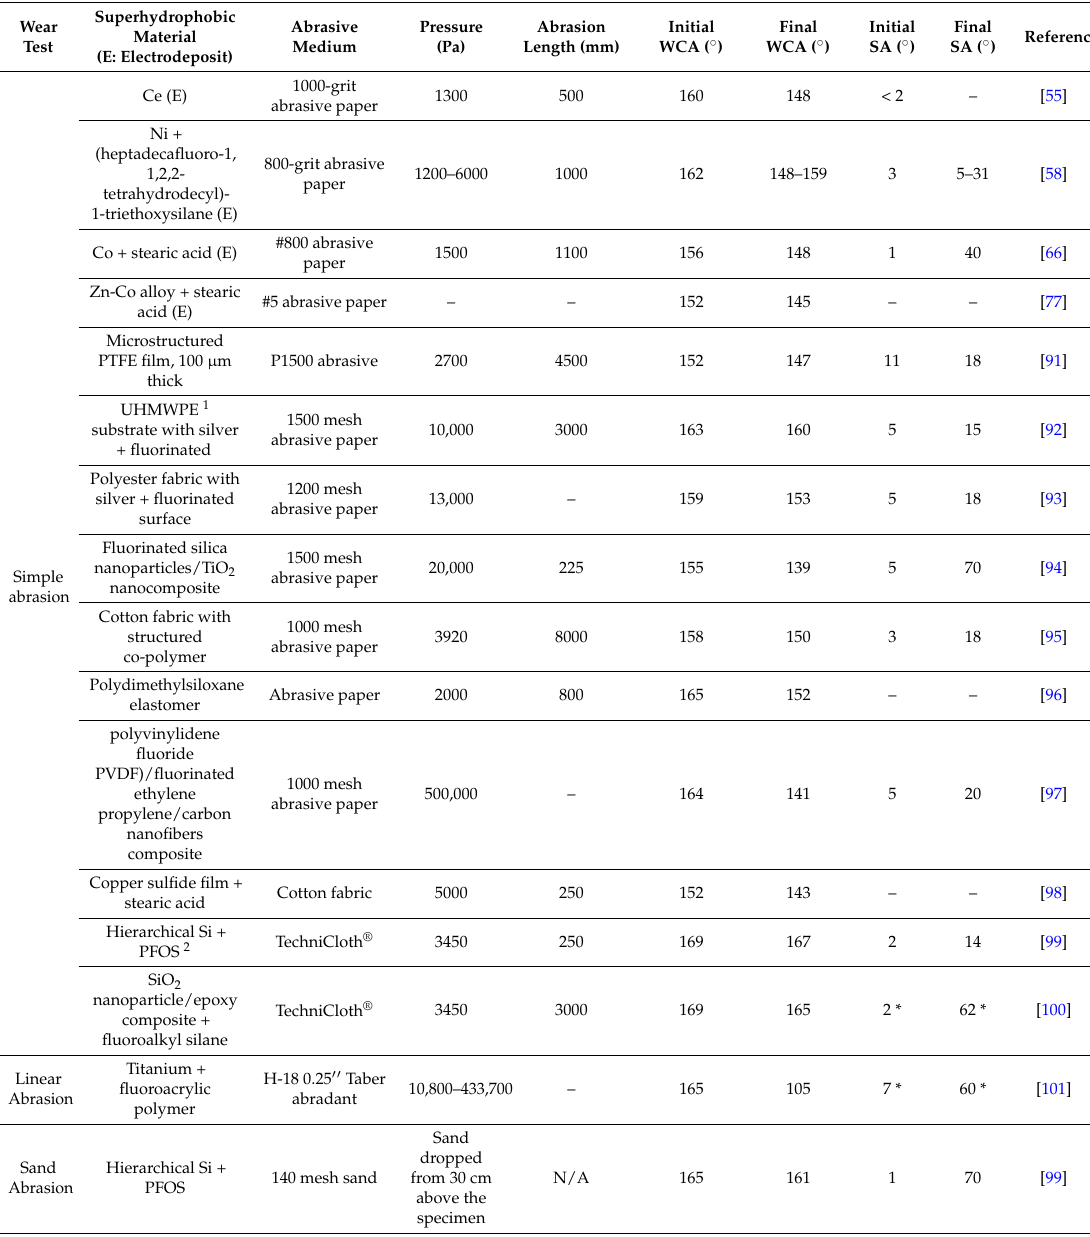
Table 2. Various wear tests of superhydrophobic